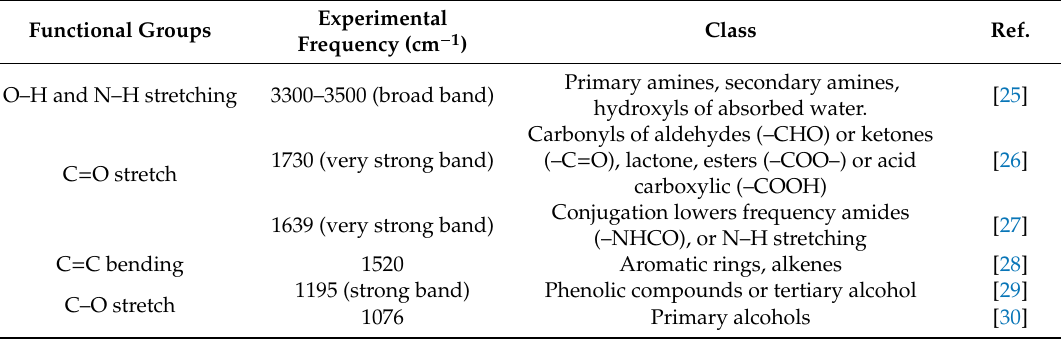
Figure 4. FT-IR spectra of EG@MnFe 2 O 4 and CR-loaded EG@MnFe 2 O 4. Table 2. The surface functional groups analysis of EG@MnFe 2 O Table 2. The surface functional groups analysis of EG@MnFe 2 O 4.